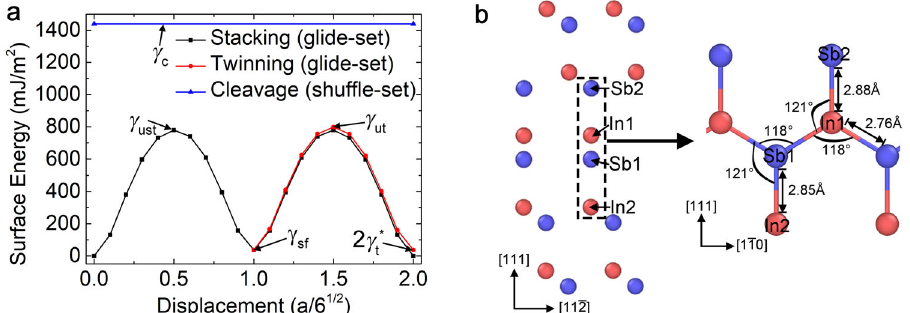
Fig. 7 The cleavage energy and GSFE curves. a The cleavage energy and GSFE curves. b Optimized model at γ ust points. In a , the maximum energy of the stacking energy curve (black square), the twinning energy curve (red circle), and the cleavage energy curve (blue triangle) are the unstable stacking energy γ ust , the unstable twinning energy γ ut , and the cleavage energy γ c , respectively. The minimum energy in the middle of stacking energy curve (black square) is the stacking fault energy γ sf and the minimum energy at the end of twinning energy curve (red circle) is the extrinsic stacking fault energy 2 γ t *. These de fi nitions are consistent with ref. 46 . In b , the section of the atoms in the black dashed rectangle is displayed on the